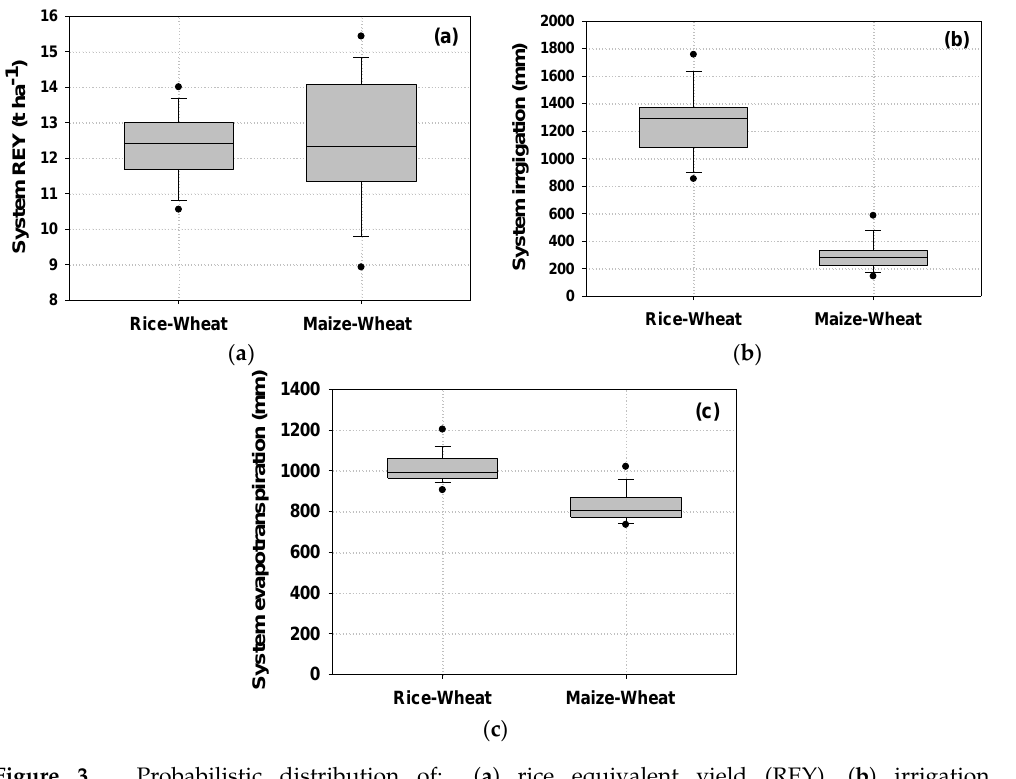
Figure 3. Probabilistic distribution of: ( a ) rice equivalent yield (REY), ( b ) irrigation, and ( c ) evapotranspiration of a rice-wheat system and maize-wheat system in central Punjab, India over 40 years (1970 – 2010). An example of how model outcome can be used to guide the field experimentation, given that testing all options in field is not feasible and are too expensive. Shaded bars are 25th – 75th percentiles; whisker caps are 10th and 90th percentile and black dots 5th and 95th percentile, horizontal line is median .